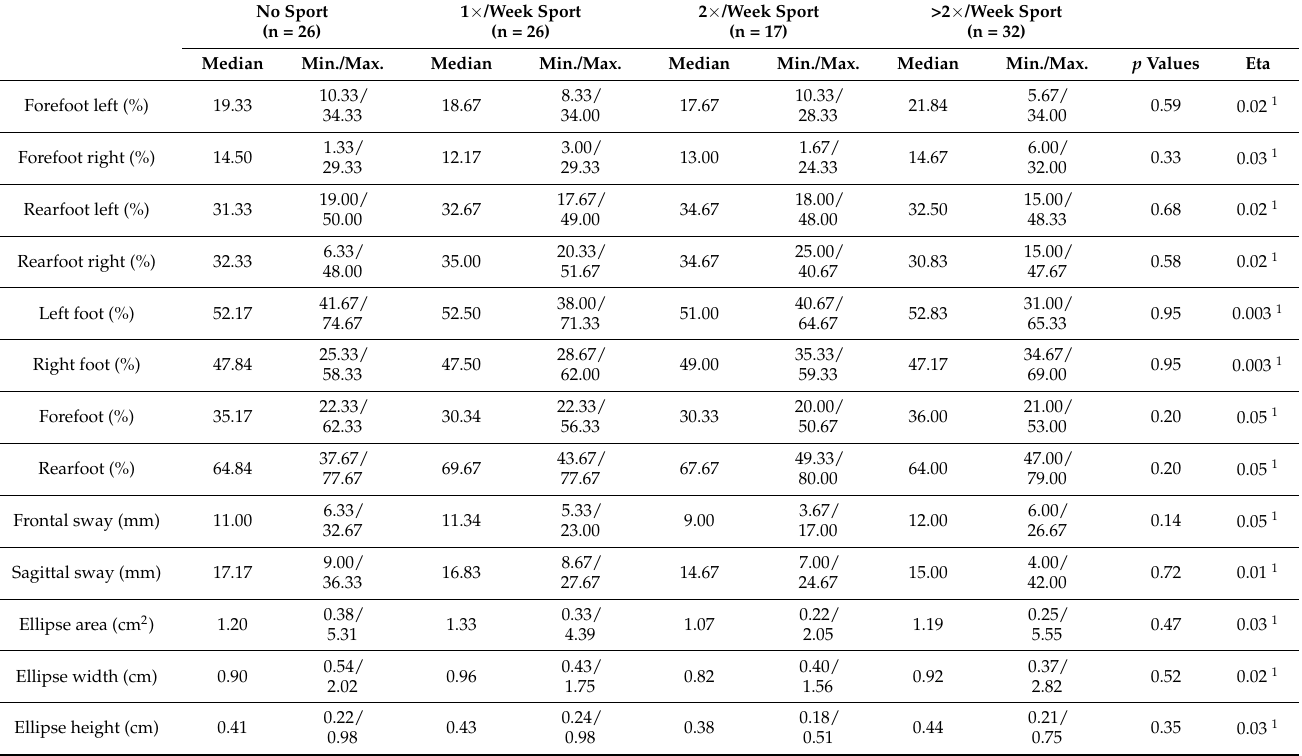
Table 4. Comparison of the parameters of the equilibrium distribution and postural sway in test subjects. Sports activity groupings: (1) No sport undertaken; (2) 1 × per week; (3) 2 × per